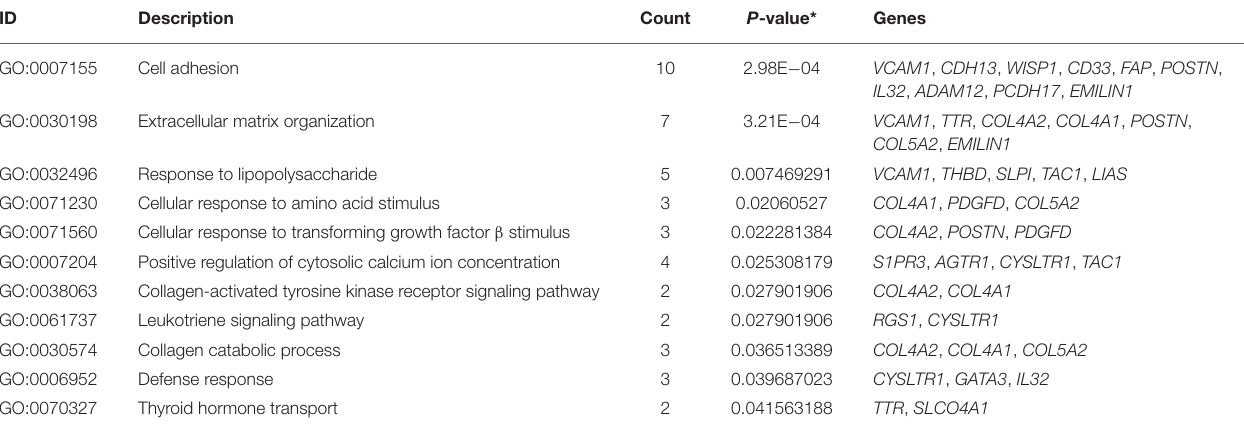
TABLE 4 | Biological processes of genes in the royalblue module in the weighted gene correlation network analysis. ID